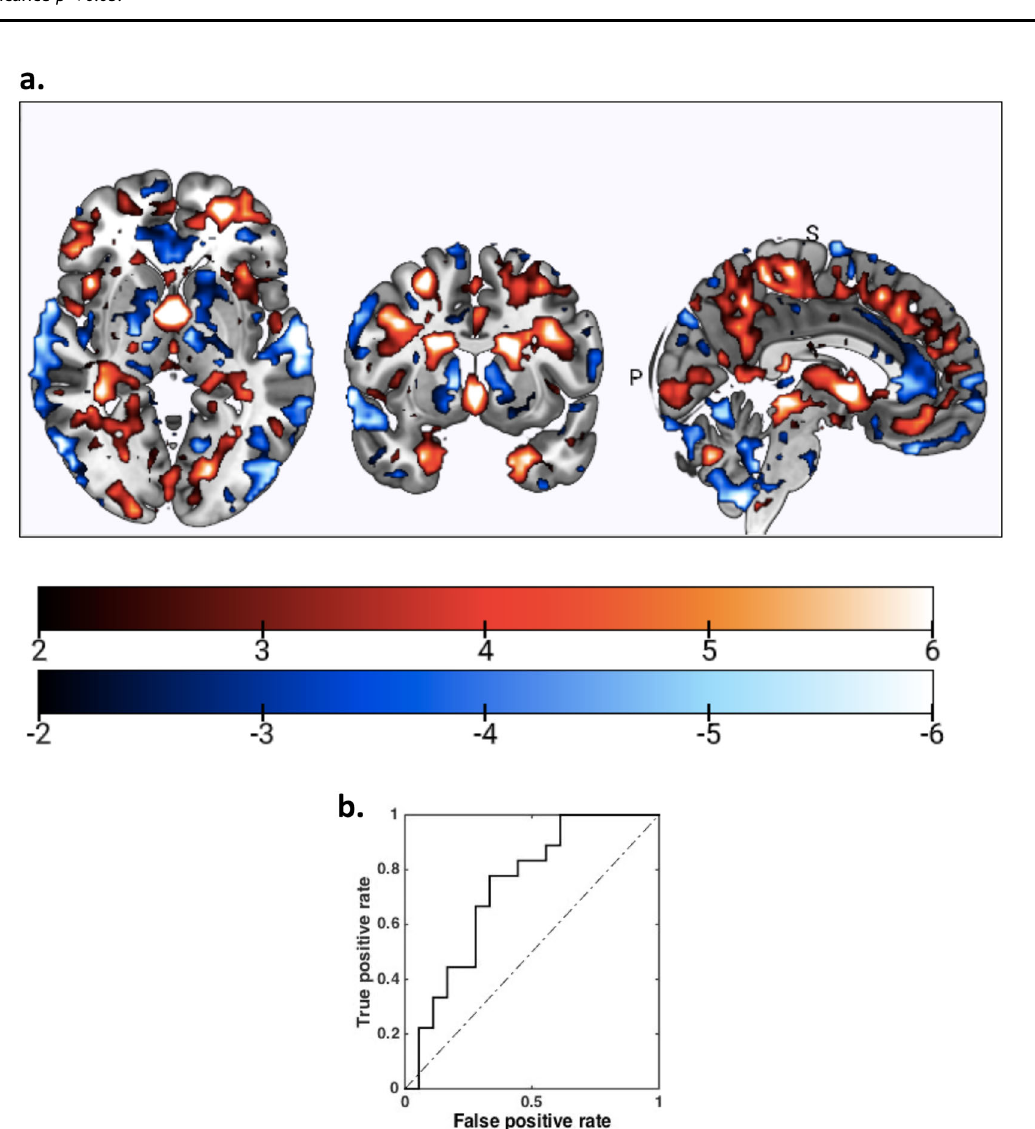
Fig. 1 Structural MRI-based classi fi ers predict functional response to auditory-based cognitive training. a . The reliability of predictive pattern elements in signi fi cant outcome classi fi cation models was measured in terms of a cross-validation ratio (CVR) map (CVR = mean(w) /standard error(w), where w is the normalized weight vectors of the SVM models. Warm color scales indicate greater vs. lower GM volumes in the SCZ subsample with post-training GAF < 45 vs. GAF ≥ 45. Cool colors indicate greater vs. lower GM volumes in the GAF ≥ 45 vs. GAF < 45 subsamples. b . Receiver-operator-curve of the class probability values obtained from the trained model in unseen SCZ persons, as determined by nested